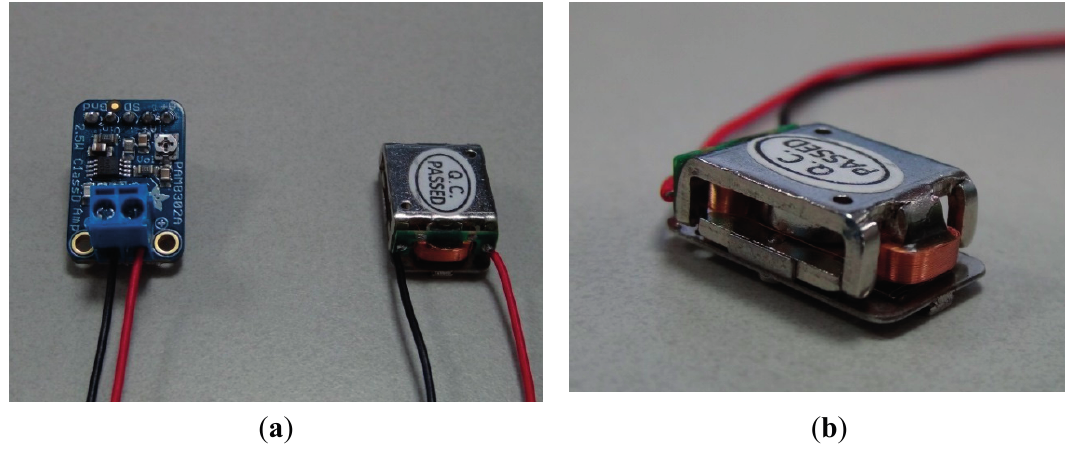
Figure 2. ( a ) The amplifier (left) and the surface transducer (right) used for the system;